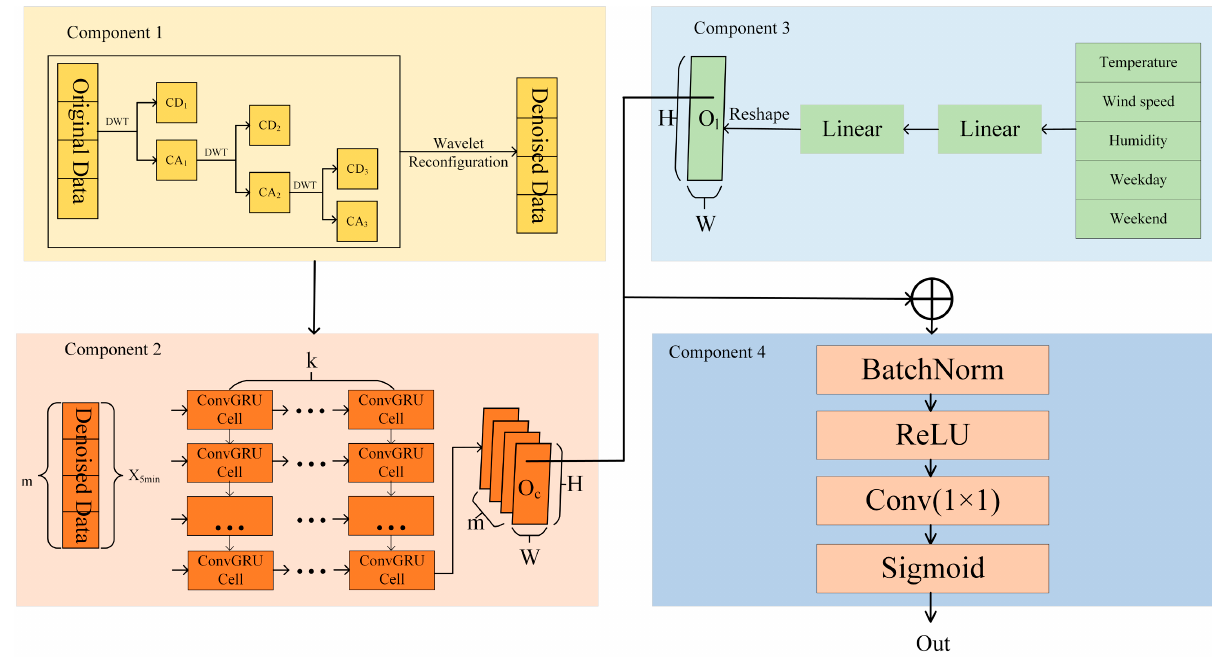
Figure 4. DWT-ConvGRU-BRC model.